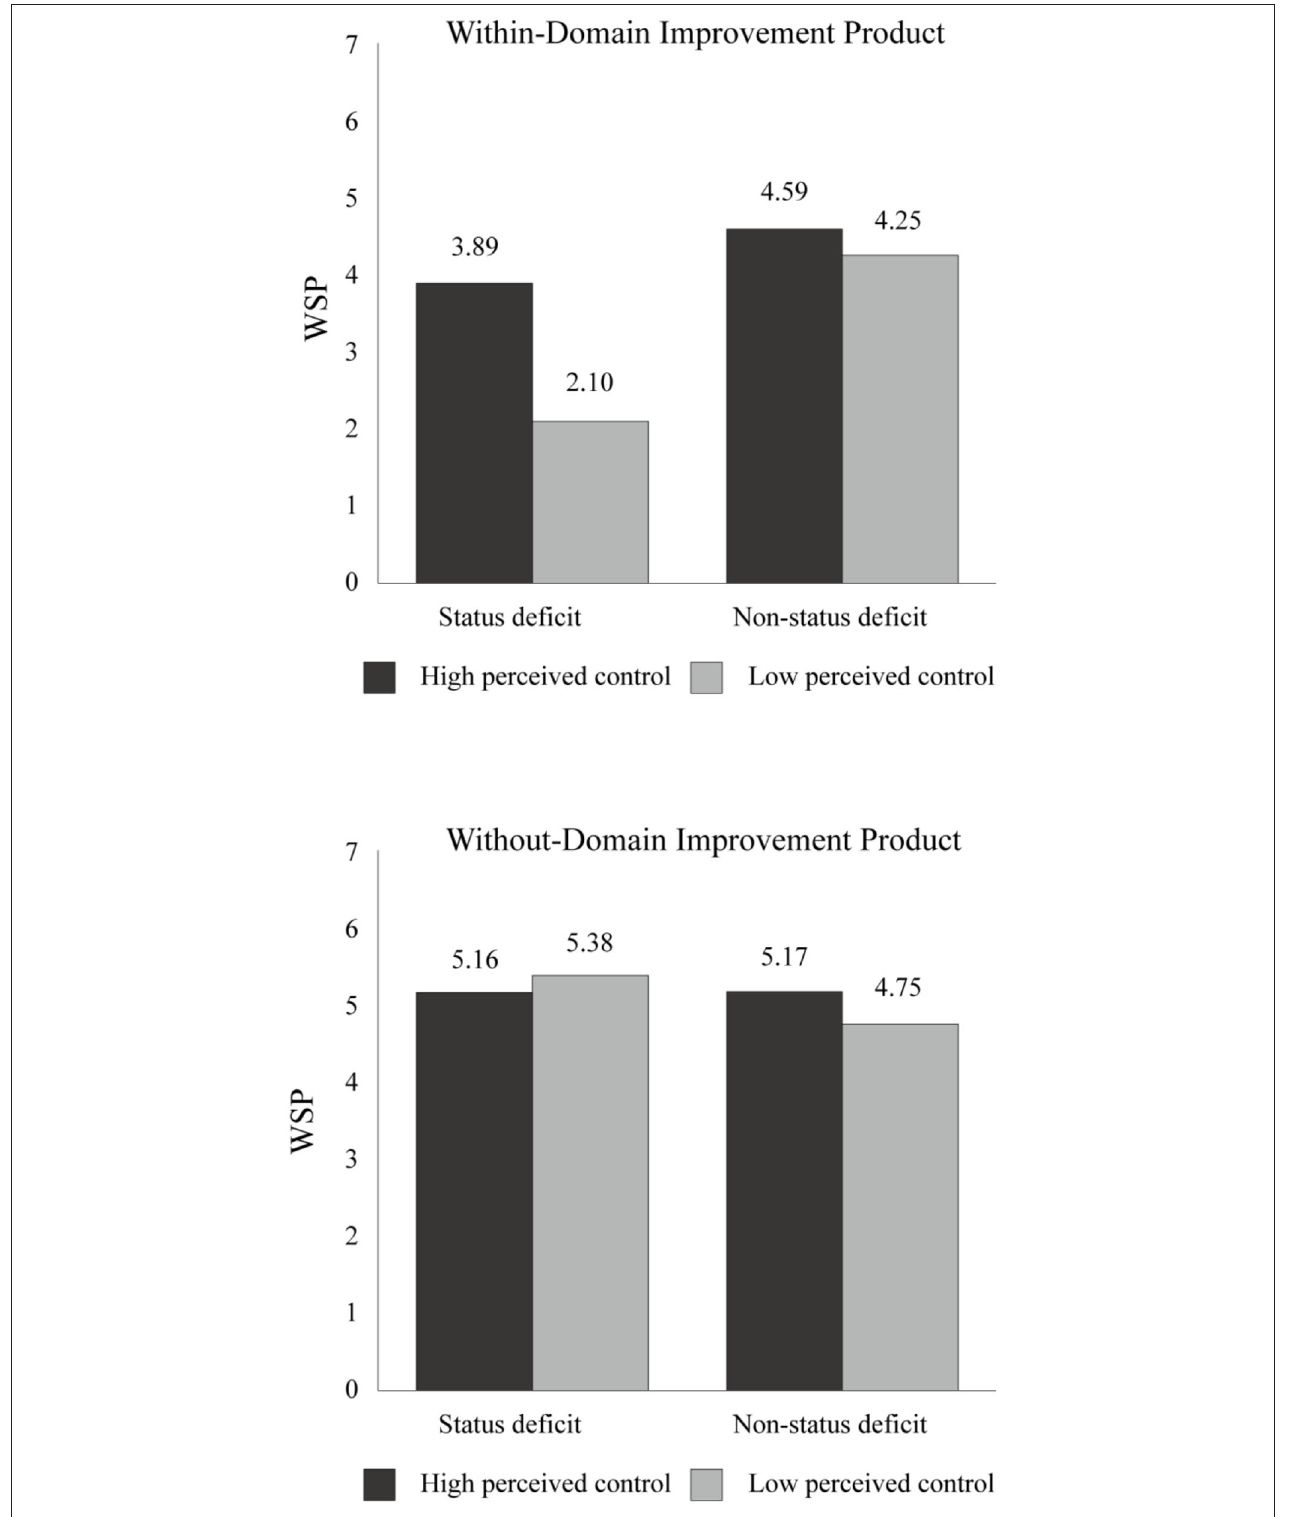
FIGURE 5 | Results of Experiment 3: willingness to purchase self-improvement products (WSP) as a function of status deficit, perceived control, and product type.